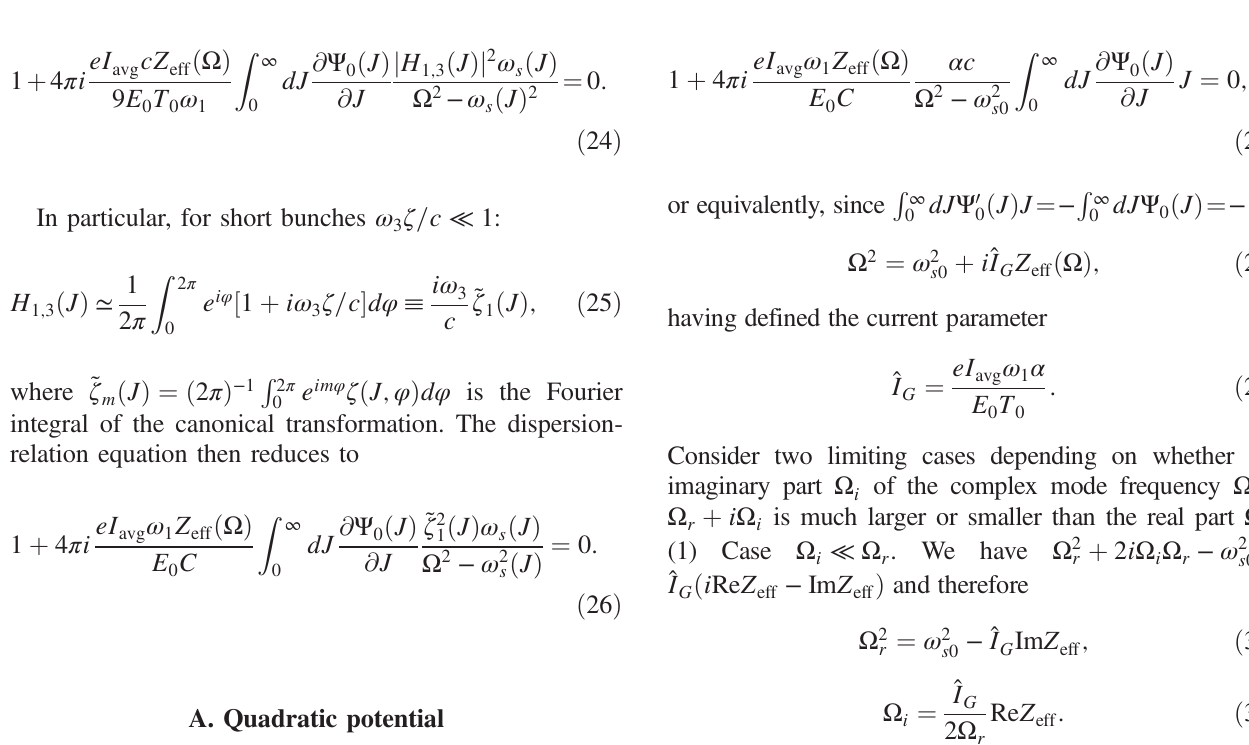
FIG. 3. Two ALS HHCs at nominal setting ( ψ ¼ 86 . 5 deg). Bunch equilibrium profile (top left), scaled rf potential Eq. (B2) (bottom left), synchrotron oscillation frequency ω s ð r Þ with the bunch equilibrium profile Ψ 0 ð r Þ in the background as a function of the amplitude variable r (top right), and phase space in the rf bucket for a few representative particle orbits (bottom